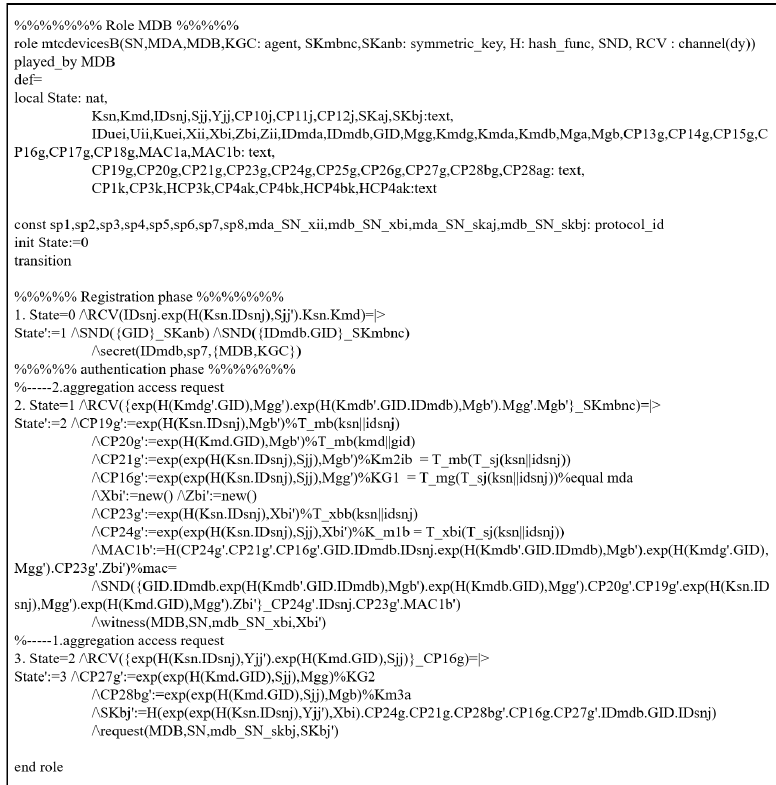
Figure 9. Scenario 2: HLPSL description of MD n